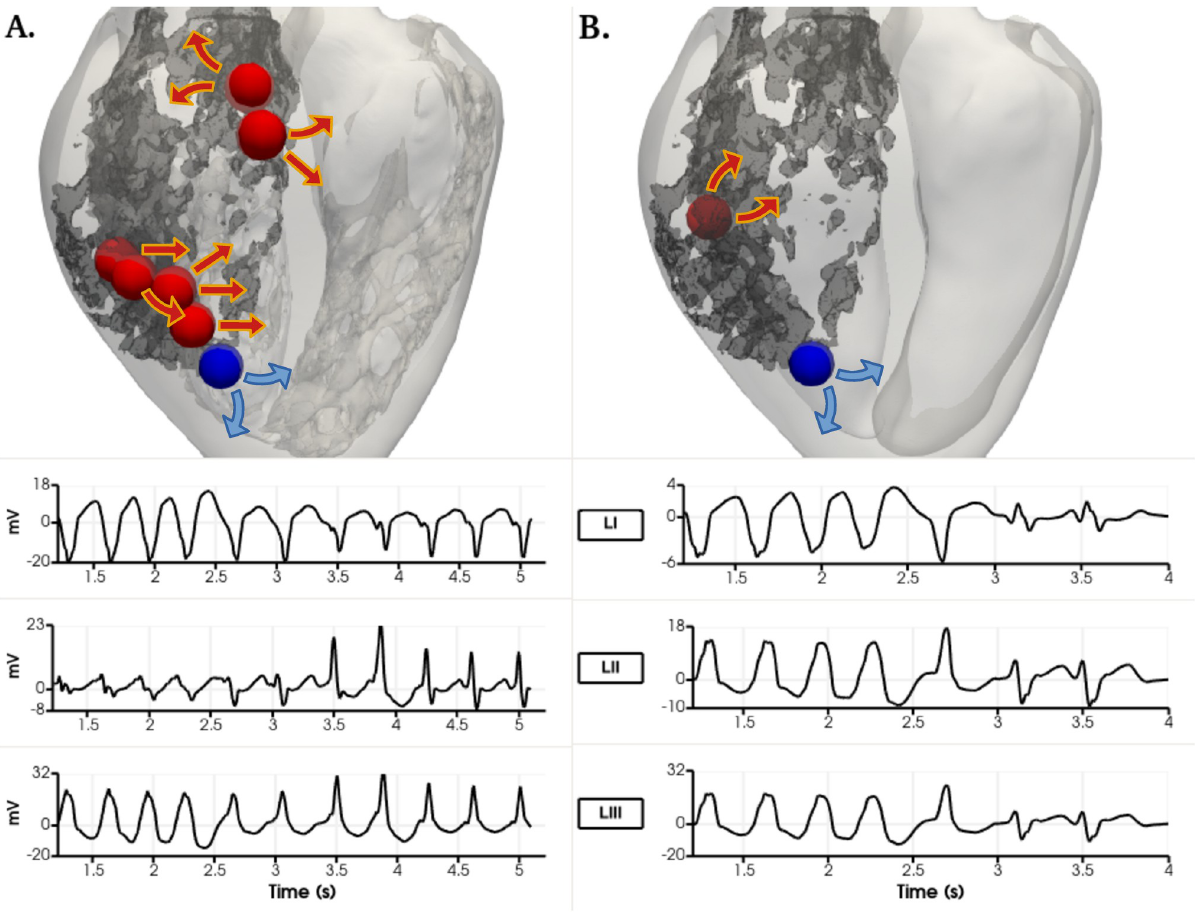
Fig 9. Ventricular tachycardia reentry channels in the female phenotype simulations with right ventricular apex stimulus location at S1 = 400, S2 = 300, S3 = 300, S4 = 300 ms. View from the epicardial posterior side of the biventricular geometry. Dense scar marked in dark grey. Arrows show the propagation wavefront of each reentry. A. Detailed geometry. B. Smoothed geometry. Their corresponding pseudo-ECG is shown below for the LI, LII and LIII leads. The sphere in blue shows the exact same reentry channel on detailed and smoothed simulations.